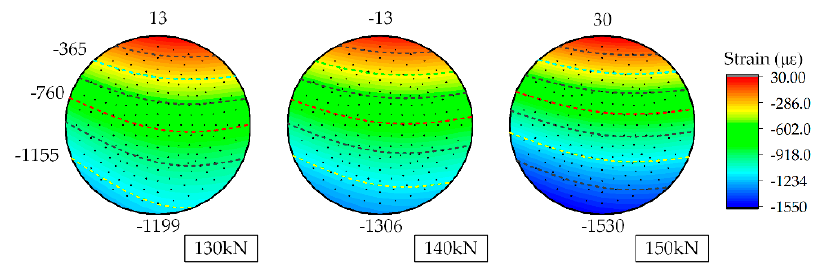
Figure 9. Strain fields of section 11 of arch-A around characteristic point P A .